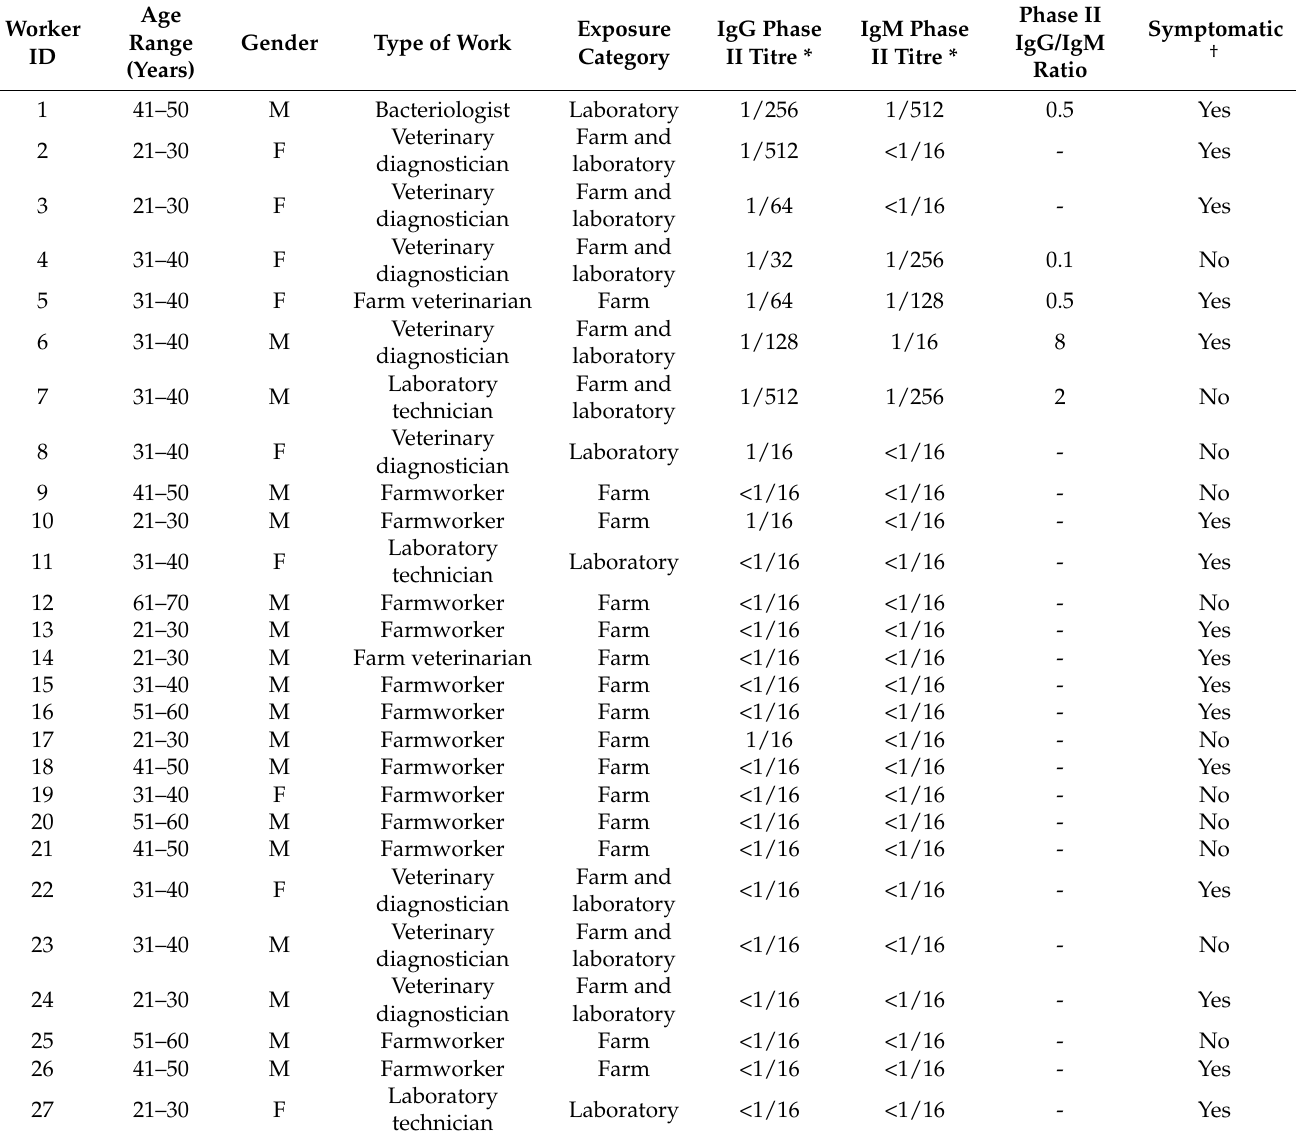
Table 1. Anti- Coxiella burnetii phase II IgM and IgG titres, IgG to IgM ratio, demographic factors, background data of workers and potential exposure based on work